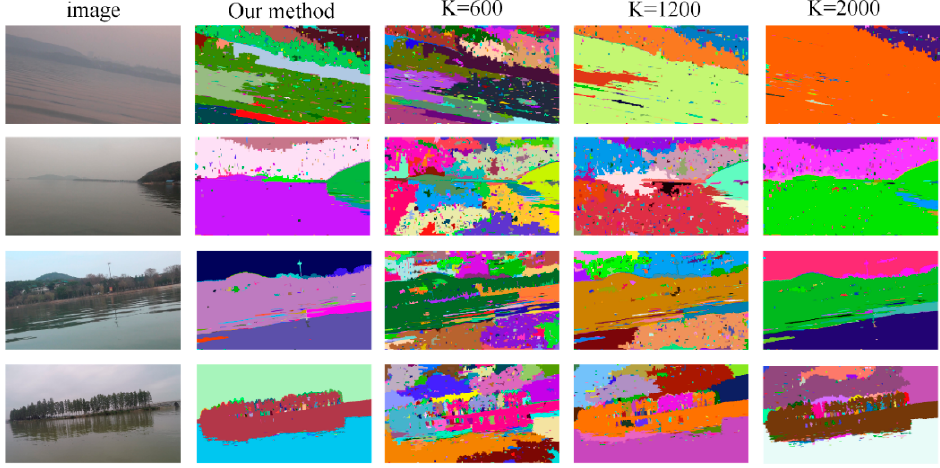
Figure 4. Adaptive segmentation result comparision.